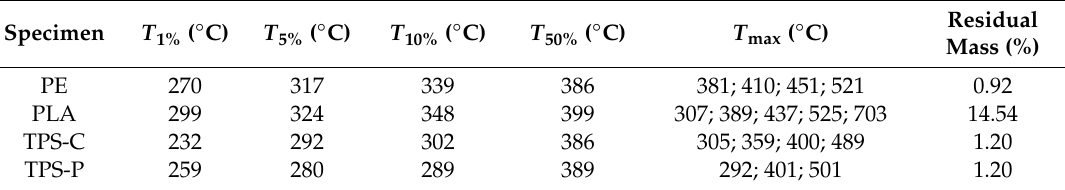
Table 4. Results obtained based on TG curves for